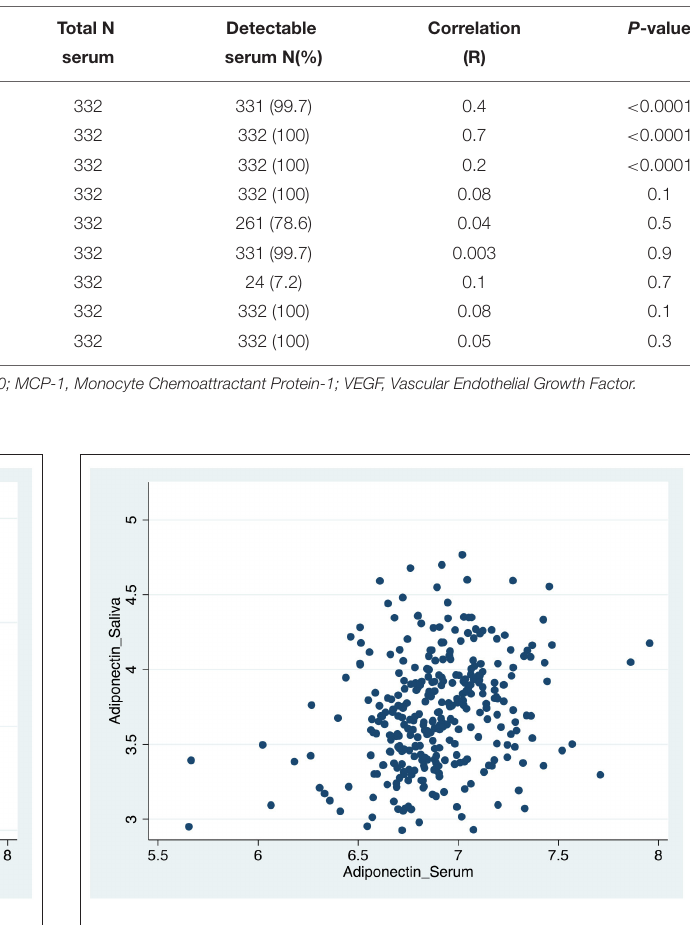
their association with obesity and intermediate hyperglycemia after adjusting for age, sex, blood pressure, and school. Higher levels of salivary CRP and insulin (OR 4.97 [95%CI: 1.66,14.90]; were associated with intermediate hyperglycemia. These